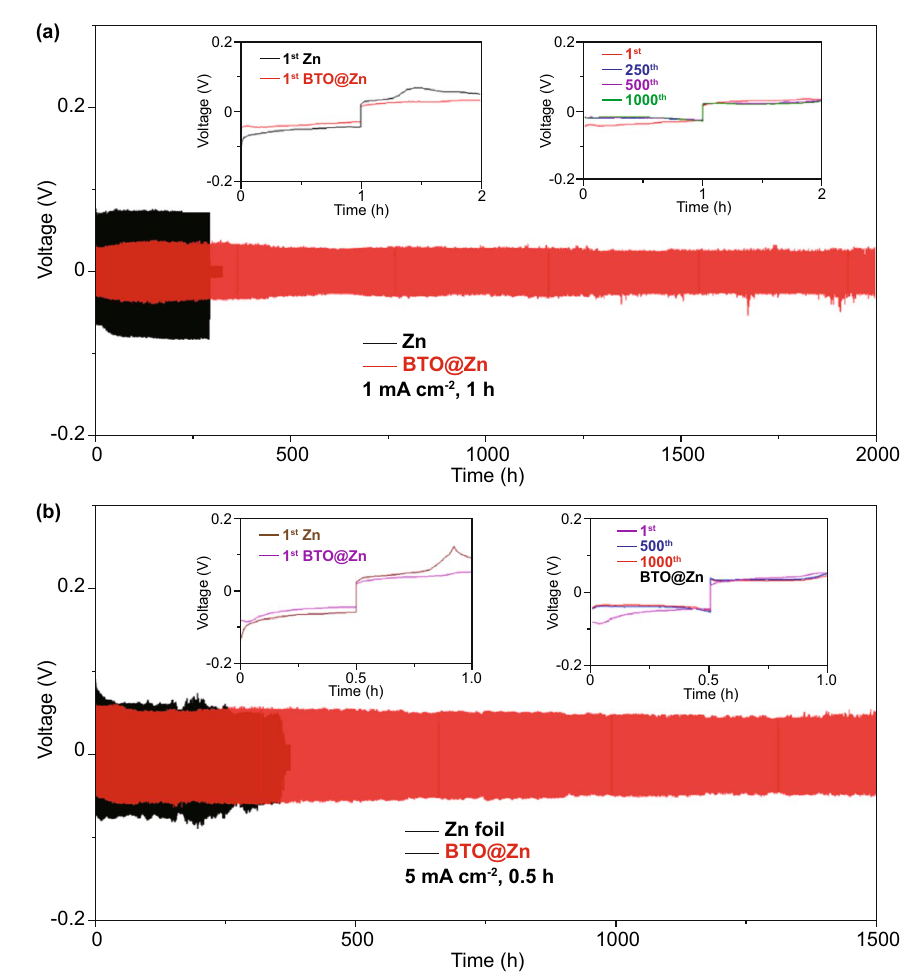
Fig. 2 Cycling performance of the symmetric cells with Zn and BTO@Zn, respectively: a at 1 mA cm −2 with capacity of 1 mAh cm −2 and b at 5 mA cm −2 with capacity of 2.5 mAh cm −2 . The insets reveal the detailed corresponding voltage profiles at various current densities and differ- ent